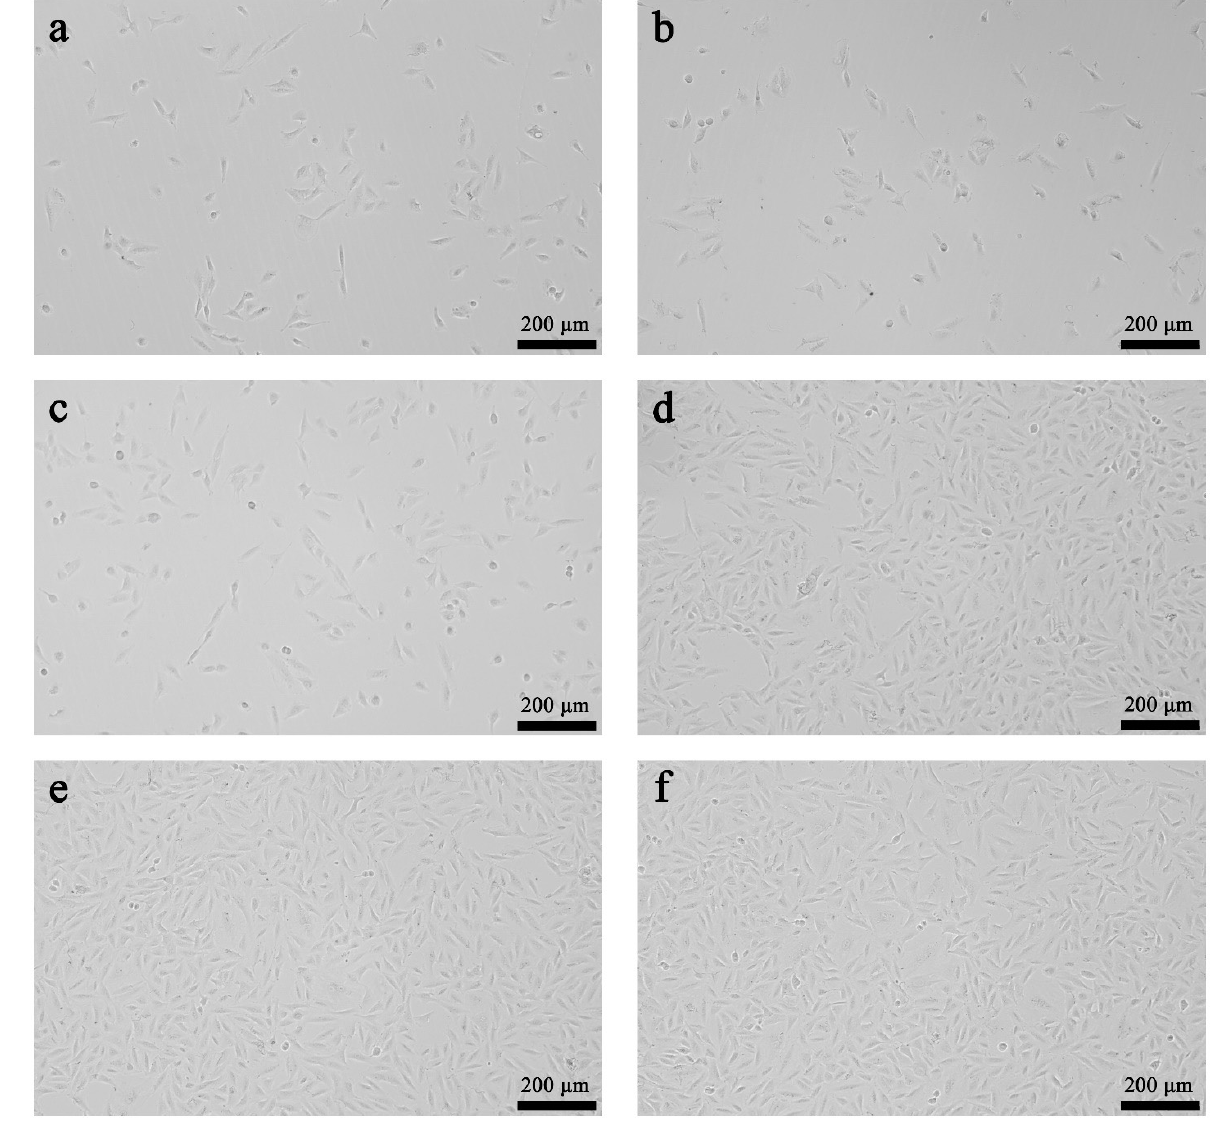
Figure 13. Images of MSCs cells on day 1 and day 5 of culture in PCL ( a , d ), CNC-3/PCL ( b , e ), and control ( c , f